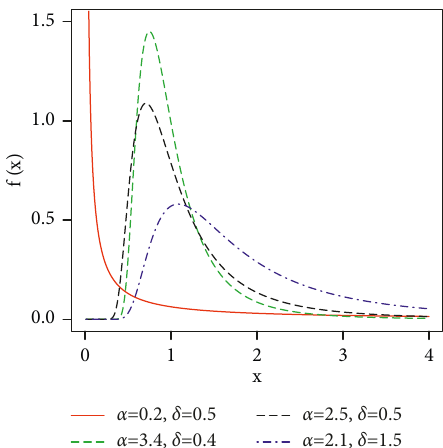
Figure 1: PDF plots of the LT-IW distribution.